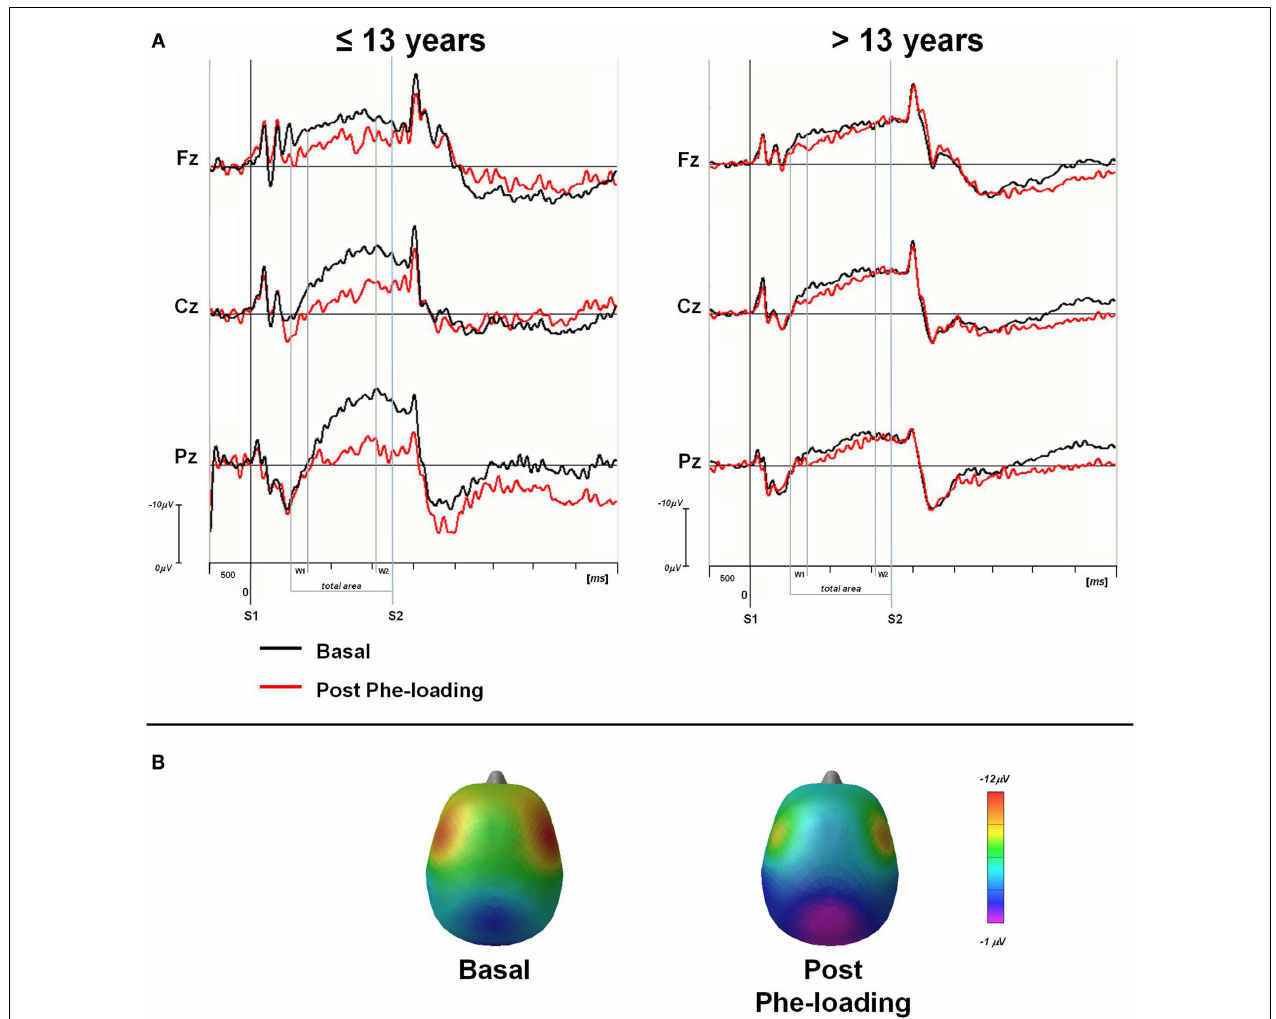
Phe-loading (red line) condition. S1: warning stimulus (flash). S2: imperative stimulus (tone). (B) Scalp potential maps at 1650ms (mean value ofW2-CNV) for ≤ 13years PKU subjects in basal and post Phe-loading